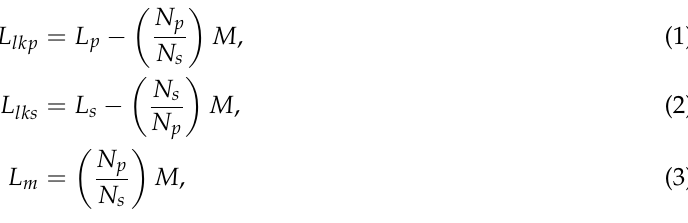
Figure 2. The magnetic model is used to calculate the magnetizing and leakage inductances, which serve as inputs to the electrical model. The magnetizing and leakage inductances are calculated